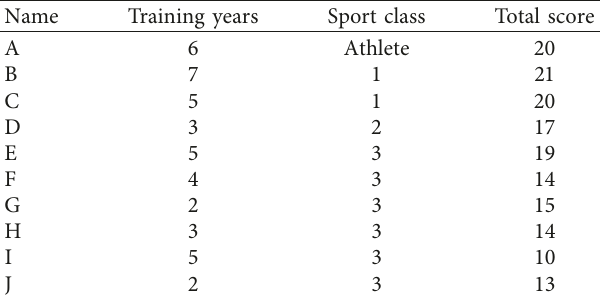
Table 1: FMS functional screening scores for track and field